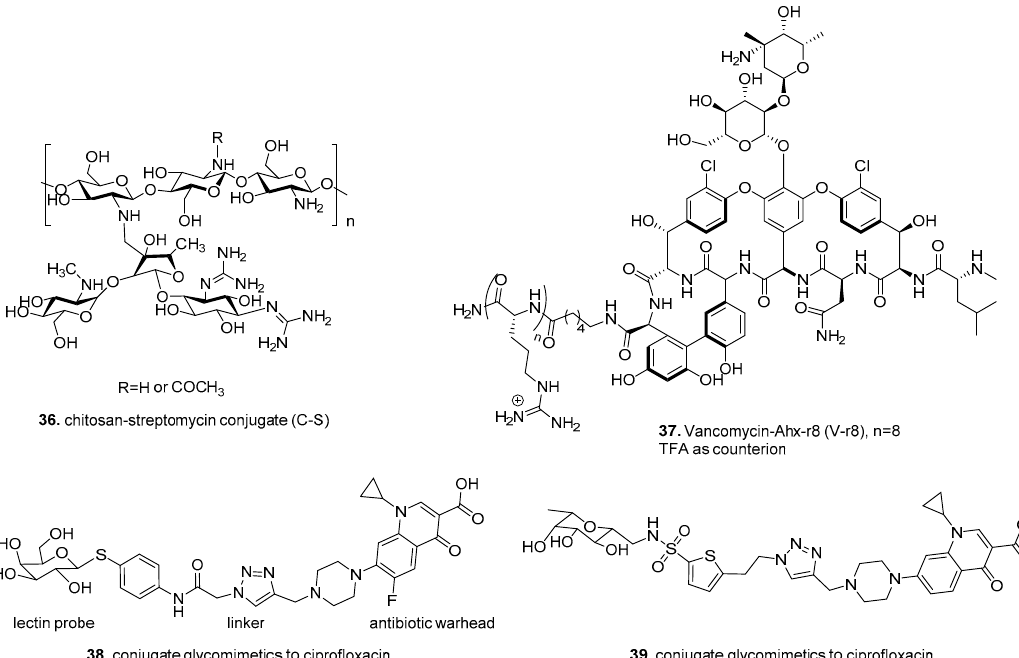
Figure 5. Therapeutic drug Figure 5 . Therapeutic drug conjugates